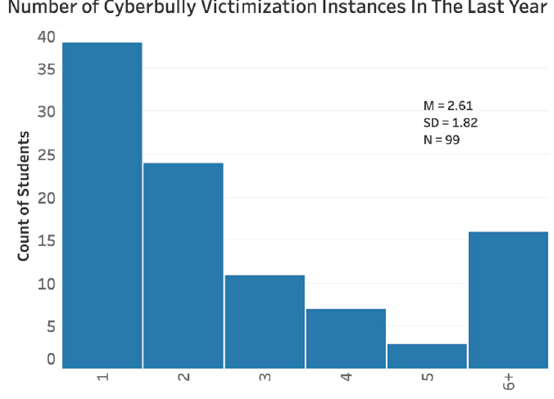
Figure 3. Frequency graph of cyberbullying victimization.